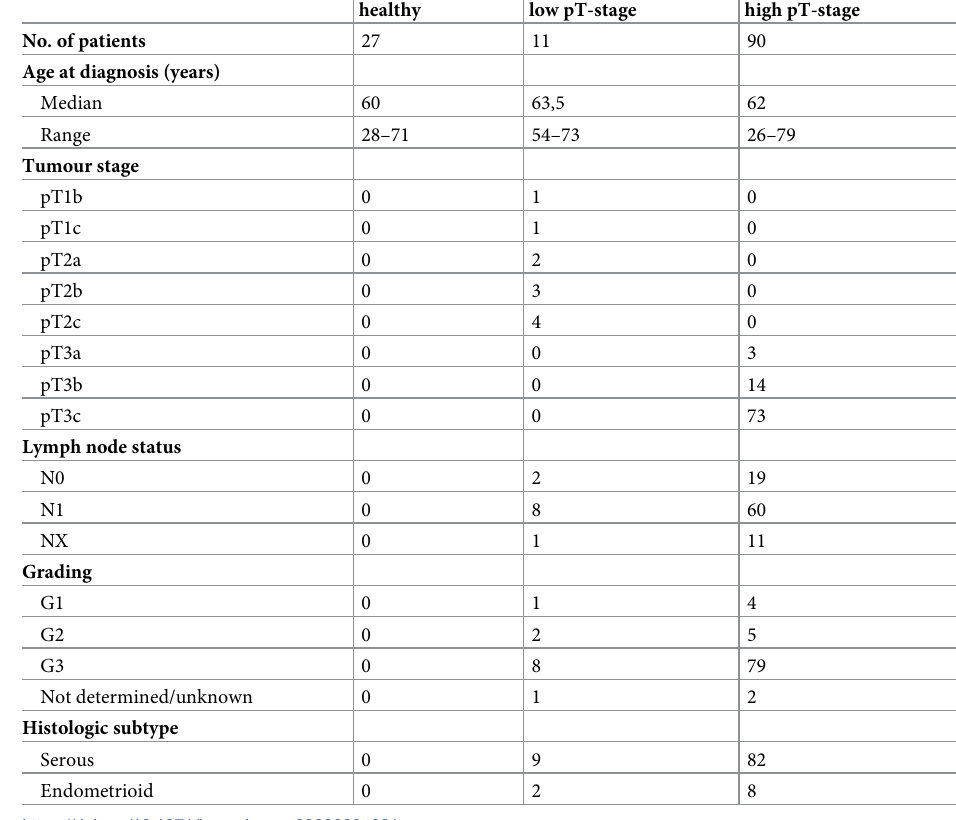
Table 1. Patient characteristics (n =